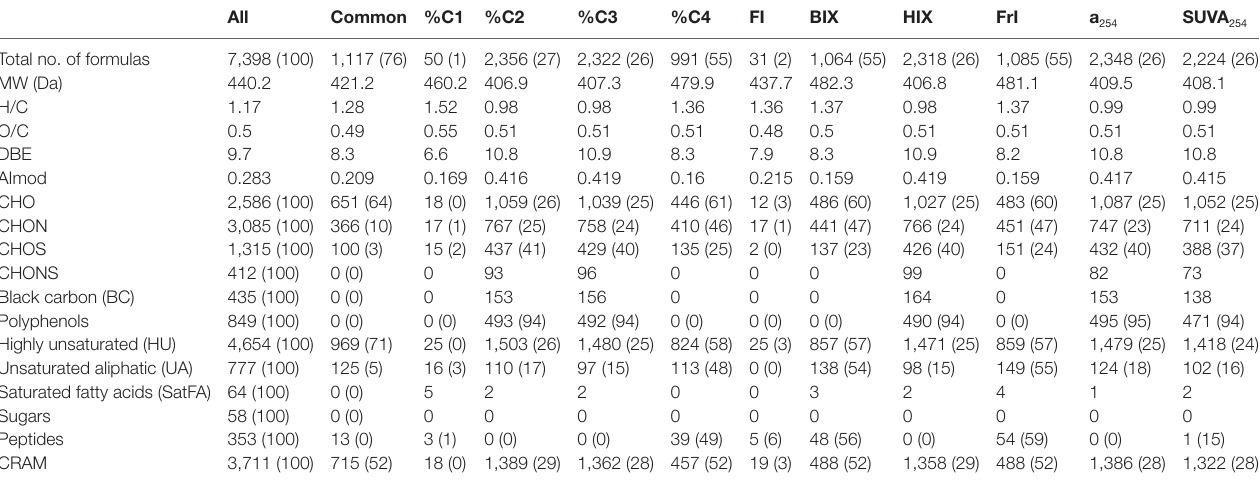
TABLE 1 | Number, average molecular mass, molecular properties, heteroatom, and formula grouping of molecular formulas that correlated positively ( r > 0, p < 0.01) with optical indices (absorption coefficient, relative abundance of PARAFAC components, SUVA 254 , FI, BIX, HIX, and FrI). All Common %C1 %C2 %C3 %C4 FI BIX HIX FrI a 254 SUVA 254 Total no. of